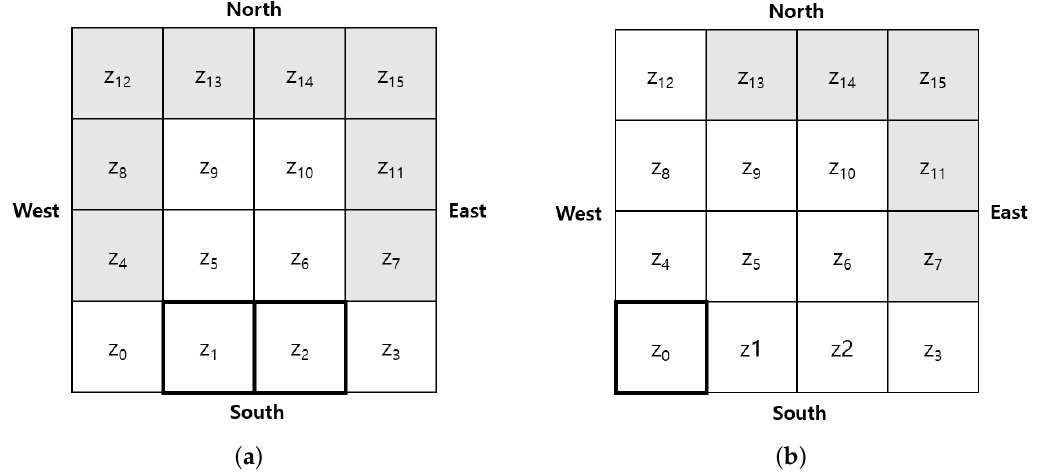
Figure 4. The examples of selecting candidates for destination border zone (shading squares are candidates for destination border zone): ( a ) the candidate border zones of z 1 and z 2 ; and ( b ) the candidate border zones of z 0 .